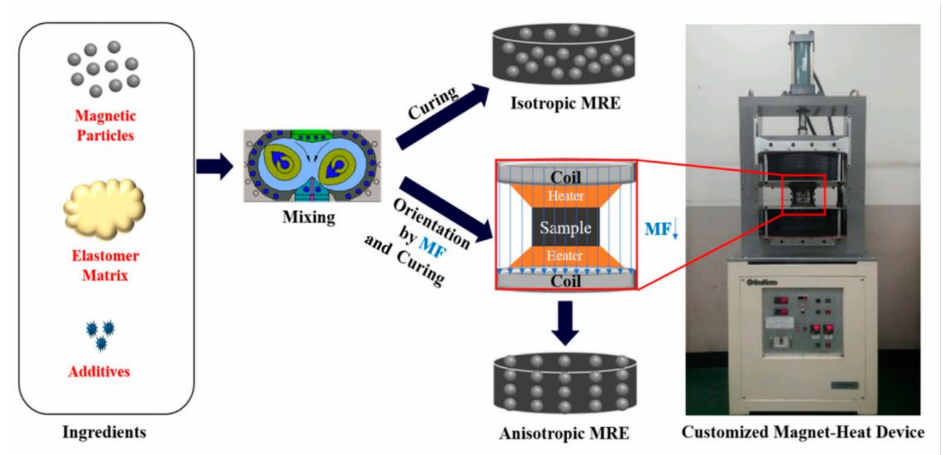
Figure 8. Schematic of the fabrication process for isotropic and anisotropic MR elastomers (Kwon et al. [84], ©MDPI, 2018).